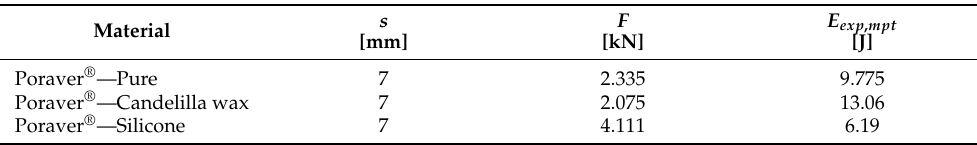
Table 4. Energy absorbed by the averaged curves of uncoated and coated particles in multi-particle compression